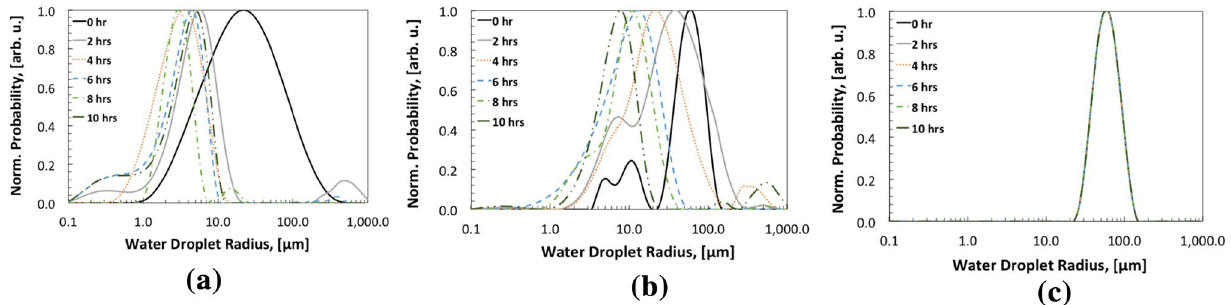
Fig. 10 Droplet size distributions for: a top, b middle and c bottom physical locations of water-in-oil emulsion formulated with AA-3 as obtained from the PFG NMR diffusion experiments